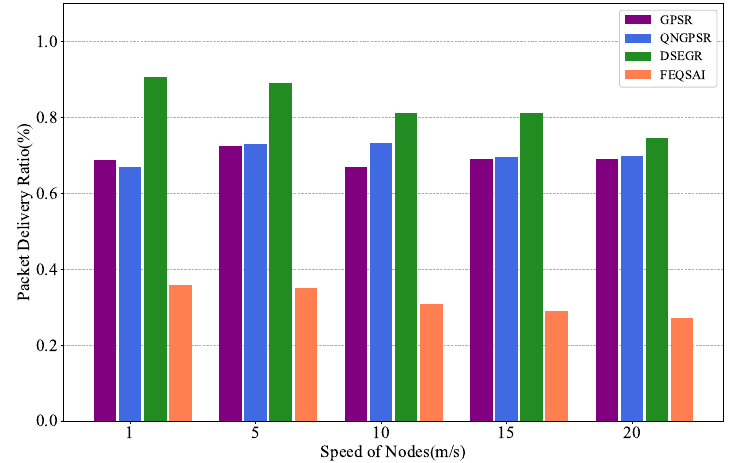
Figure 6. Performance comparison of the PDR among GPSR, QNGPSR, DSEGR, and FEQSAI with different nodes’ movement speeds.